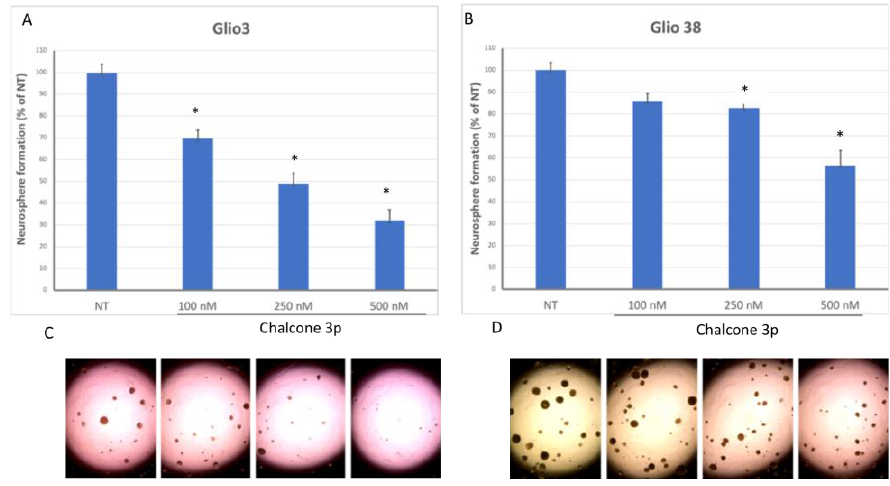
Figure 2. Effect of chalcone 3o on GSC neurosphere formation. GSCs were dissociated and single cells plated in 96 well plates (approximately 50 cells/well) and treated with chalcone 3o at concentrations shown. Fourteen days later, the number of neurospheres greater than 100 microns was determined for Glio3 ( A ) and Glio38 ( B ). Data presented as percent of non-treated controls. * p < 0.01. Representative images are shown for Glio3 ( C ) and Glio38 ( D ).